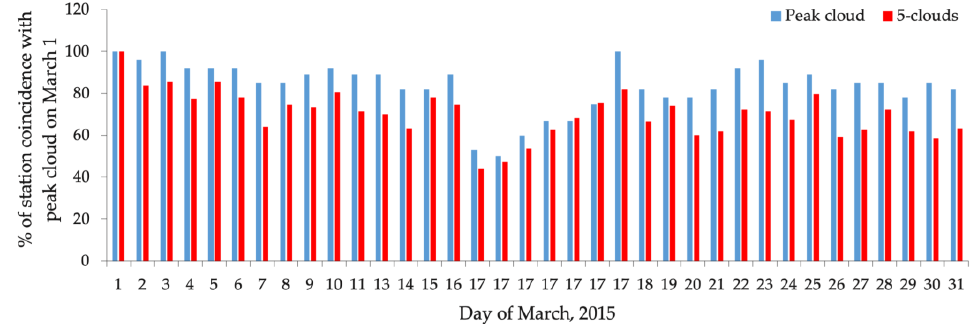
Figure 11. The percentage of coincidence of subsets in the intersection of the peak cloud on March 1, with peak clouds on other days (subsets ∊ P) in March (in blue), and a summary of the intersection of all five-cloud subsets on 1 March, with five-cloud subsets on other days (subsets sets ∊ P′) (in red). The comparison of discrepancy clouds on March 1 with the seven clouds on March 17 revealed that the percentage of common stations was <50% at the beginning of March 17 (Table S9). However, the count of common stations in the peak cloud, by the end of the day, reached 100%, which fits the trend of the peak event time series (Figure 11 and Table 2) for the whole month of March. Table 2. Time of the max peak on March 17 (Time S) compared to the peaks of the nearest ‘calm’ days (Time C).